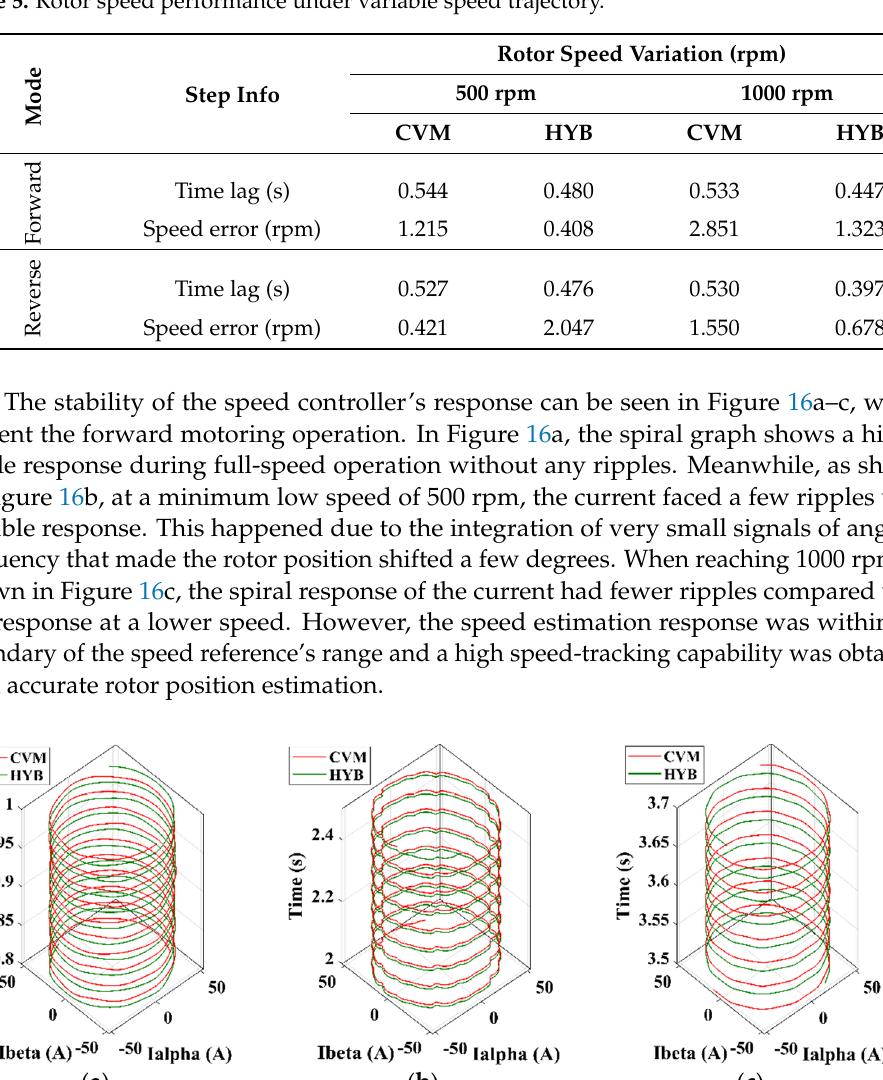
Table 5. Rotor speed performance under variable speed trajectory.